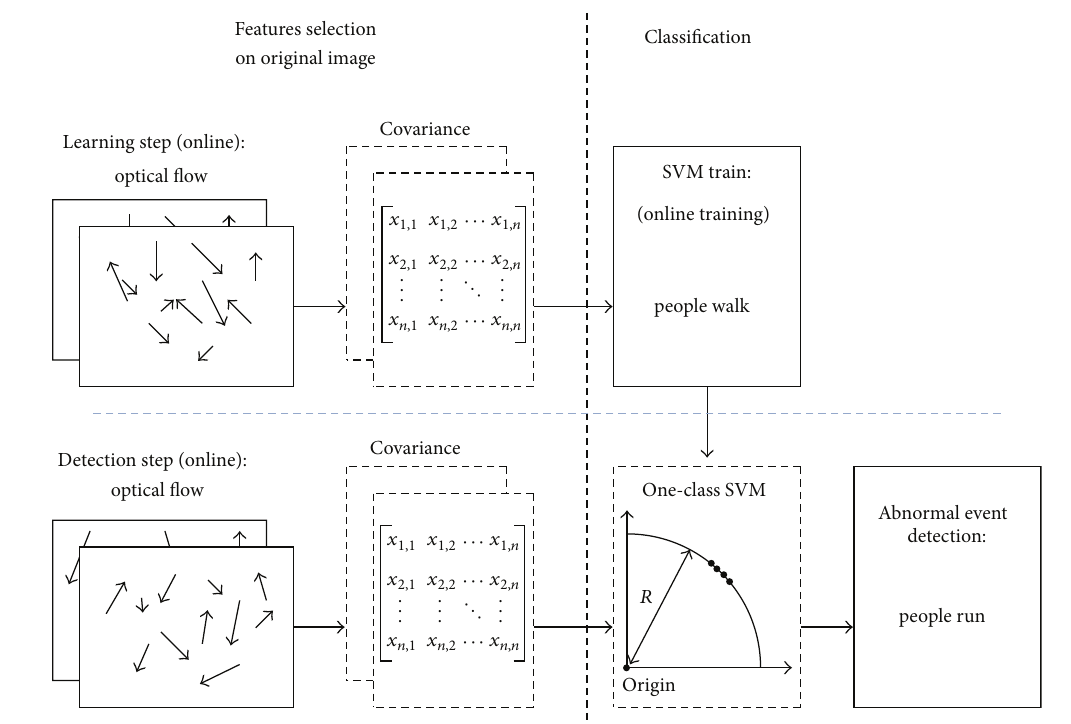
Figure 4: Major processing states of the proposed abnormal frame event detection method. The covariance of the frame is